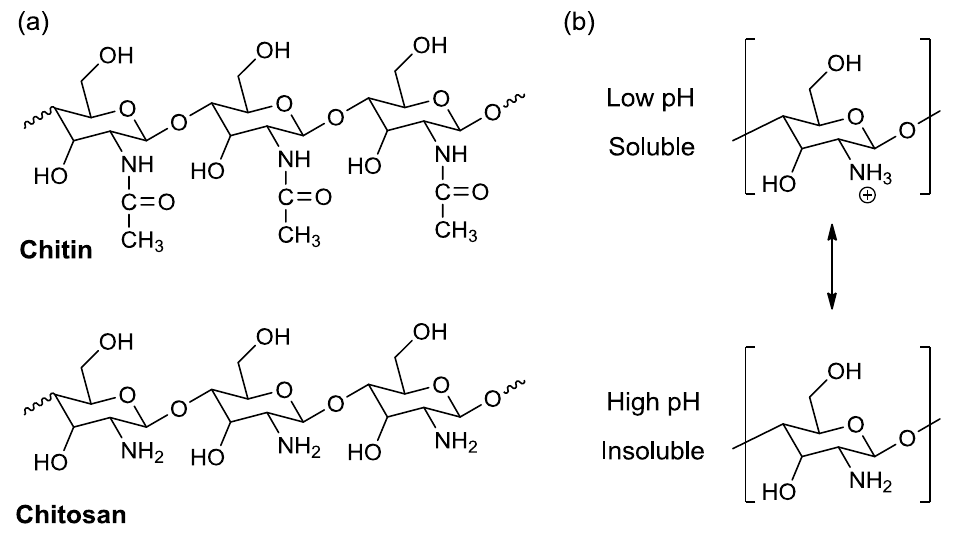
Figure 3. ( a ) Chemical structures of Chitin and Chitosan (CS); ( b ) Schematic illustration of chitosan’s